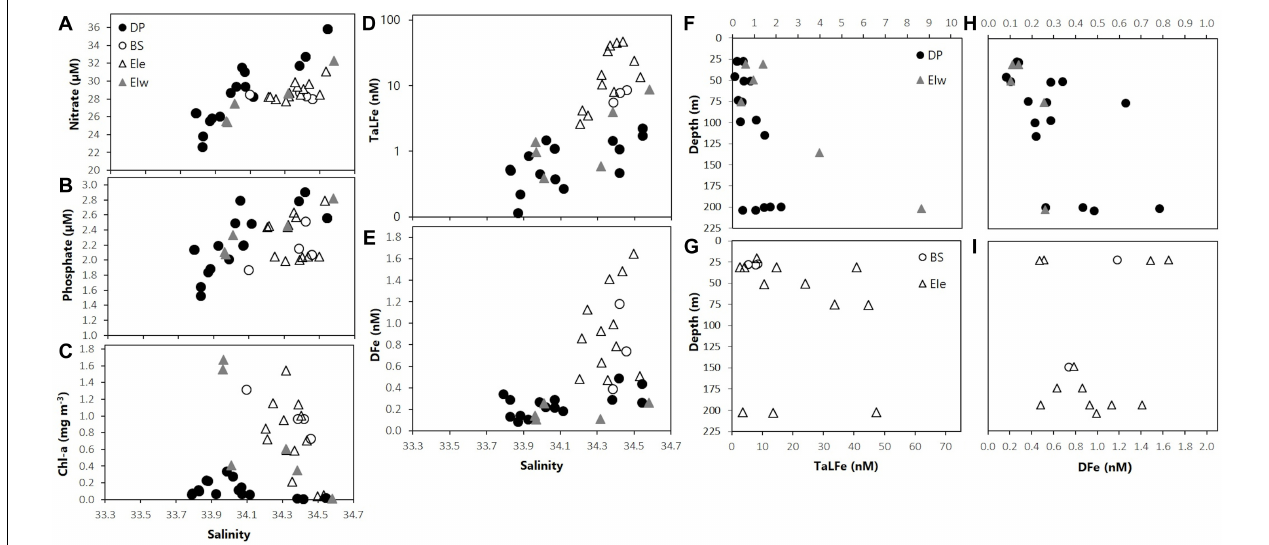
FIGURE 3 | (A) Nitrate ( µ M), (B) phosphate ( µ M), (C) Chl-a (mg m - 3 ), (D) TaLFe (nM), and (E) DFe (nM) distribution in relation to salinity; (F,G) TaLFe (nM) and (H,I) DFe (nM) distribution in relation to depth (m) for all groups of stations in the SSI 2007. Note logarithmic scale for panel (D) . DP, Drake Passage area; BS, Bransfield Strait area; EIe, East Elephant Island area; EIw, West Elephant Island